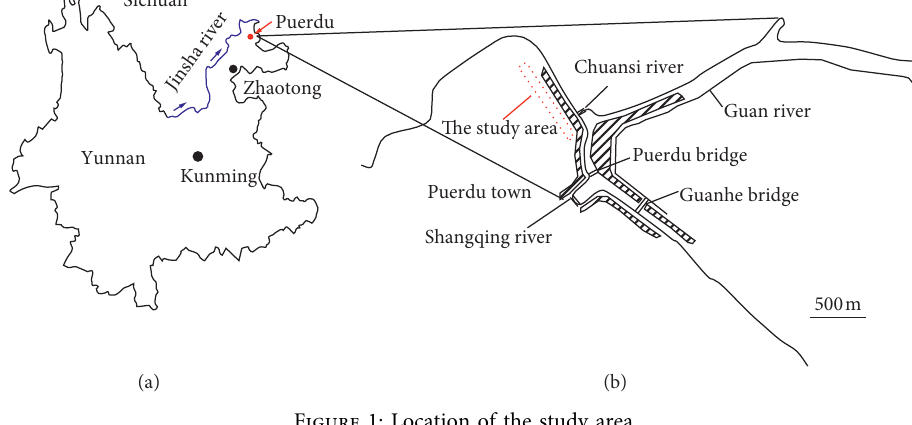
Figure 1: Location of the study area.